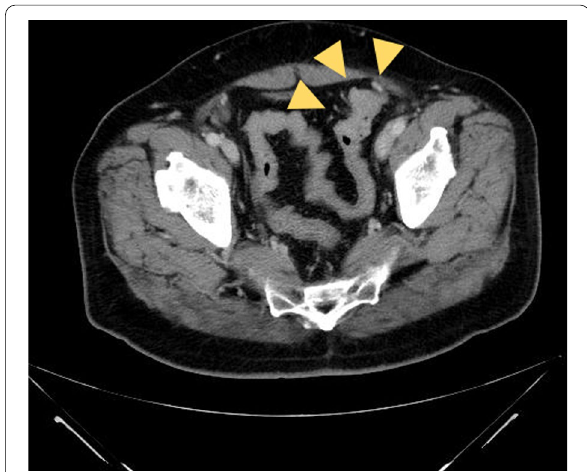
Fig. 3 Abdominal computed tomography findings. Abdominal computed tomography image shows a contrast-enhanced lesion in the sigmoid colon (yellow arrow). There are no metastases or